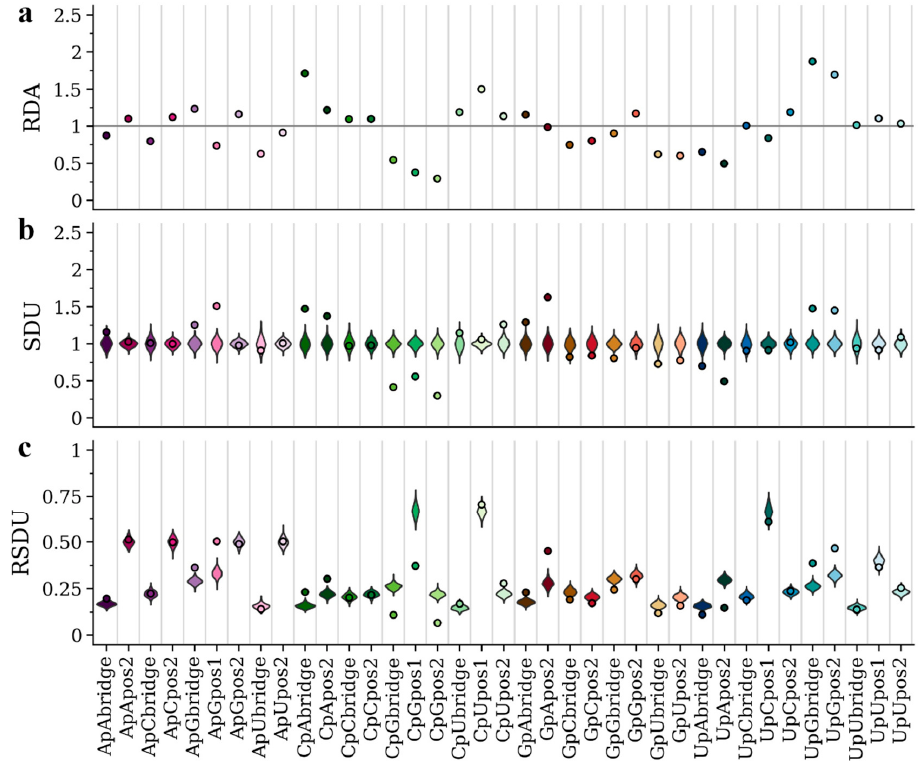
Figure 2. RDA ( a ), SDU ( b ) and RSDU ( c ) values for all informative dinucleotides and frame positions plotted for the APOIV coding sequence. Dot points indicate observed values and violin plots indicate SDU / RSDU error distributions around the null hypothesis (1000 random samples for each value). The grey horizontal line indicates an RDA of 1. Position 1 of dinucleotides CpC, CpA, GpC, GpG, GpU, GpA, UpG, UpA, ApC, ApU, ApA are excluded because they can only produce one amino acid (non- informative).